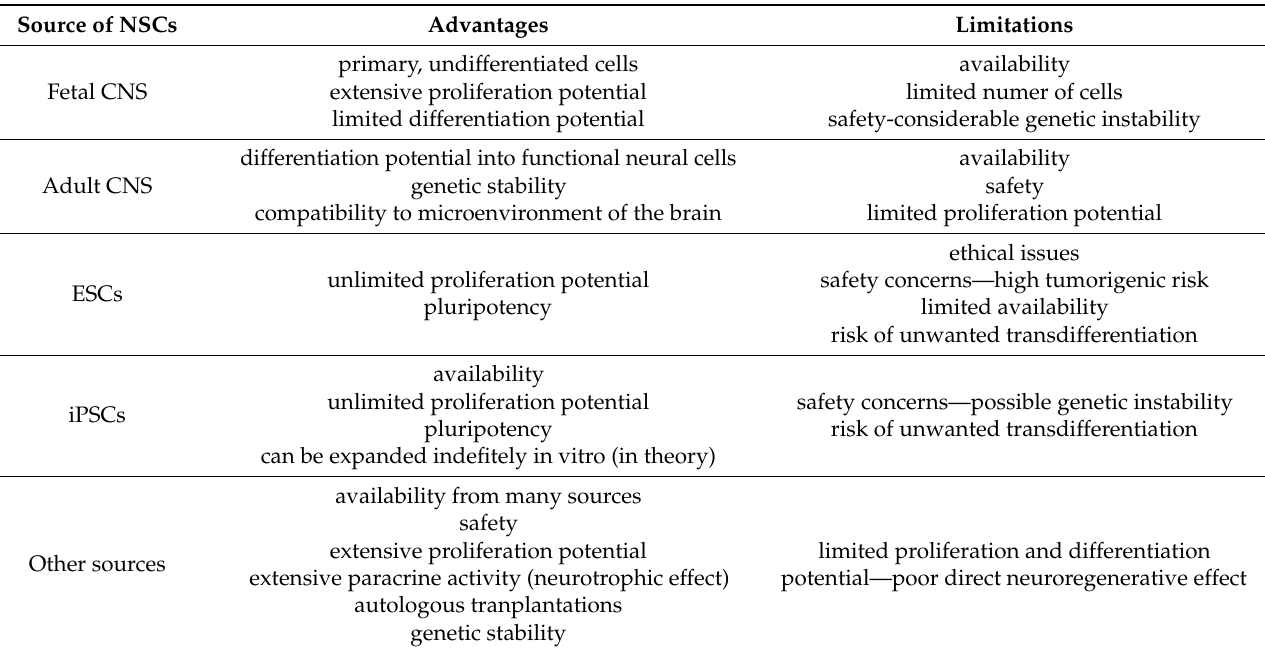
Table 1. The summary of potential advantages and disadvantages according to use of different neural stem cells sources in cell-replacement therapy